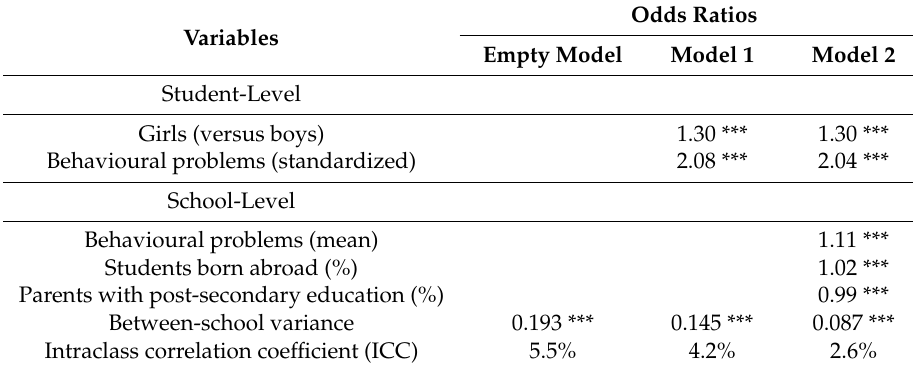
Table 2. Multilevel logistic regressions predicting bullying victimization (59,510 sixth-grade students distributed across 1999